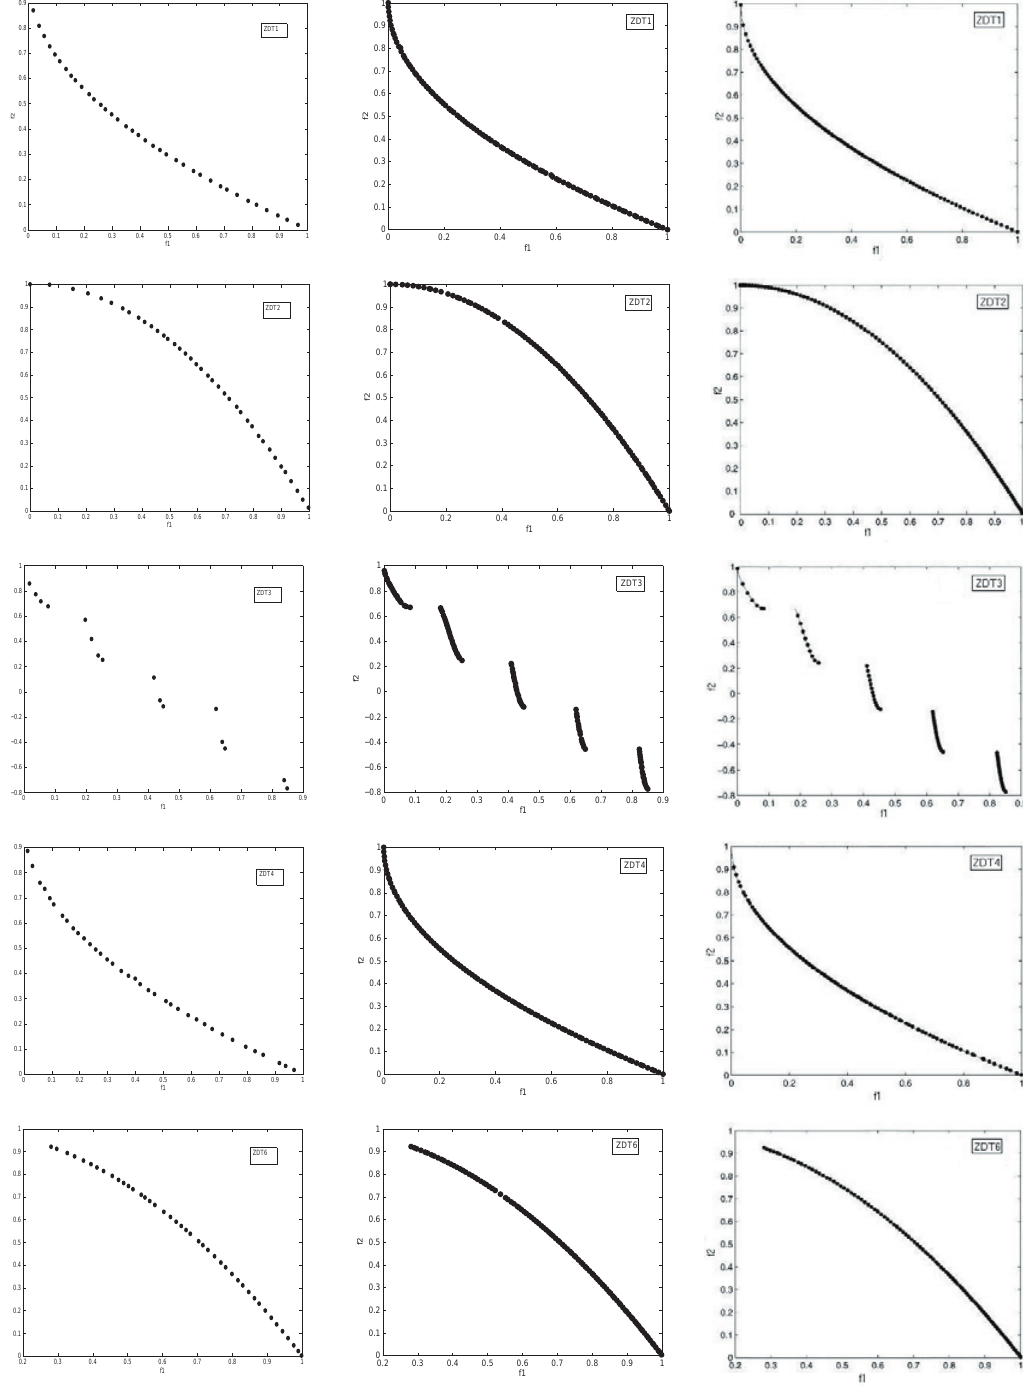
Fig. 7. PFs obtained by SDE, PLSDE and MOEA/D for five 2-objective test instances. The left column is for SDE, the middle one for PLSDE and the right one for